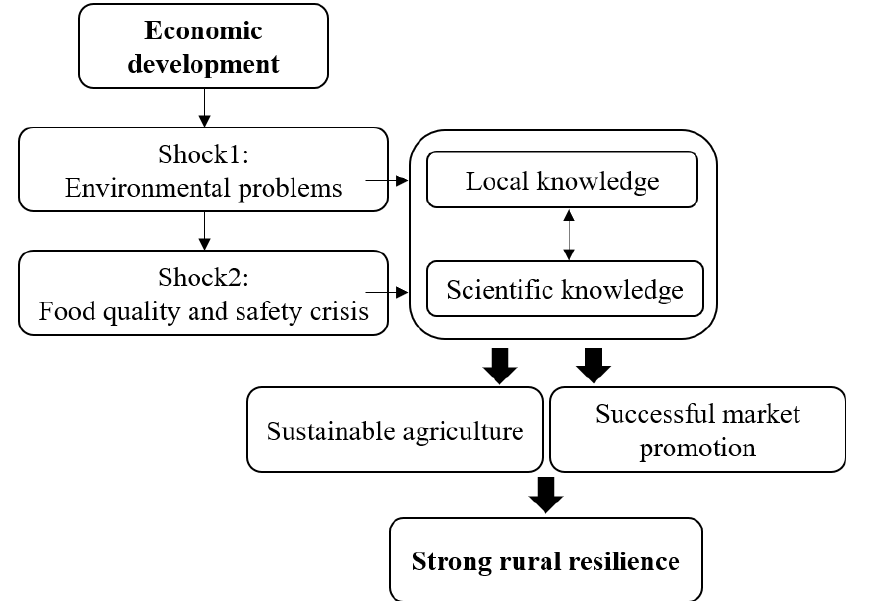
Figure 4. The theoretical framework shows how knowledge production contributes to strong rural resilience.